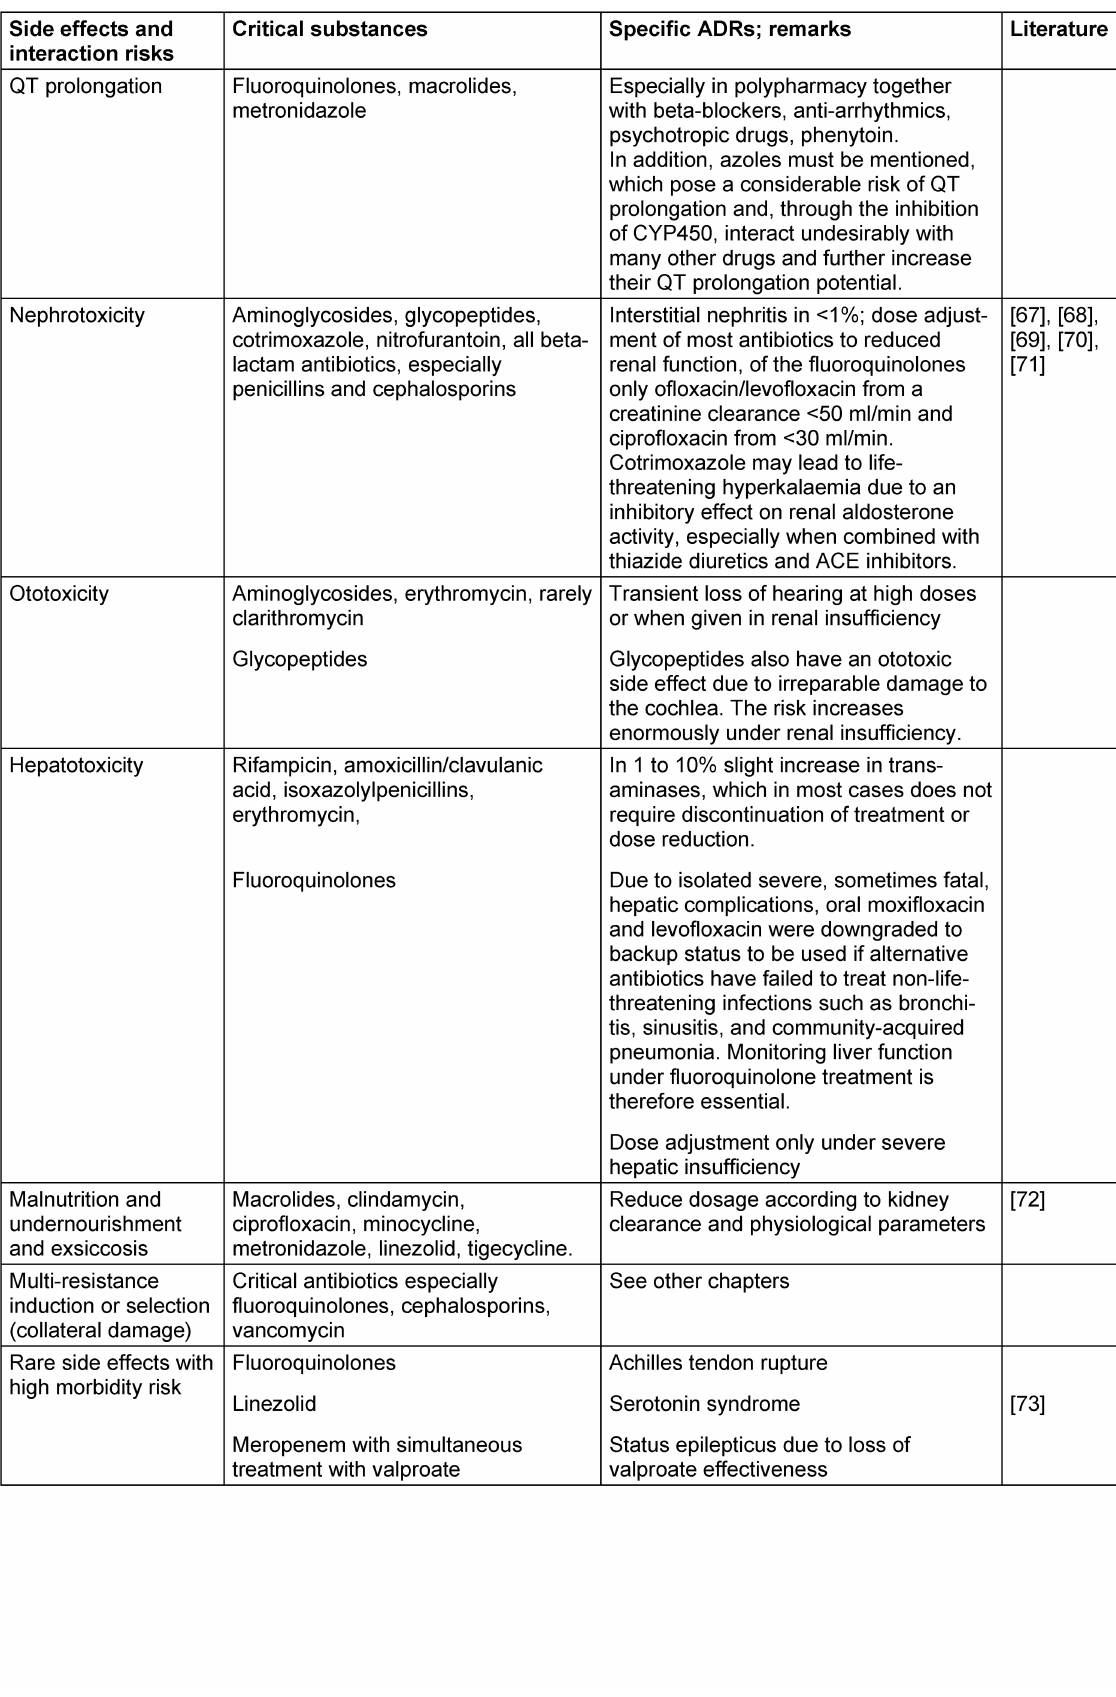
Table 3: Evaluation of the individual antibiotic classes or individual substances according to side effects and risk of